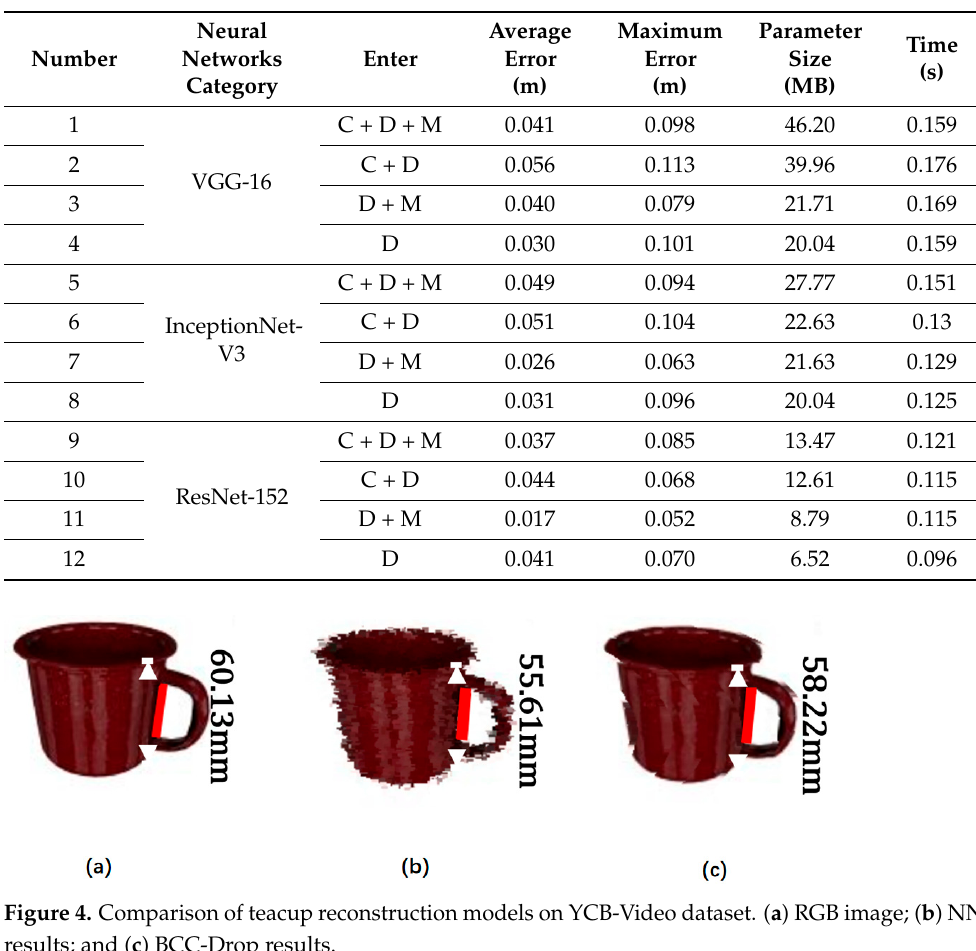
Table 3. The results of joint coding of different input combinations and different types of CNN depth recovery on the YCB-Video dataset.